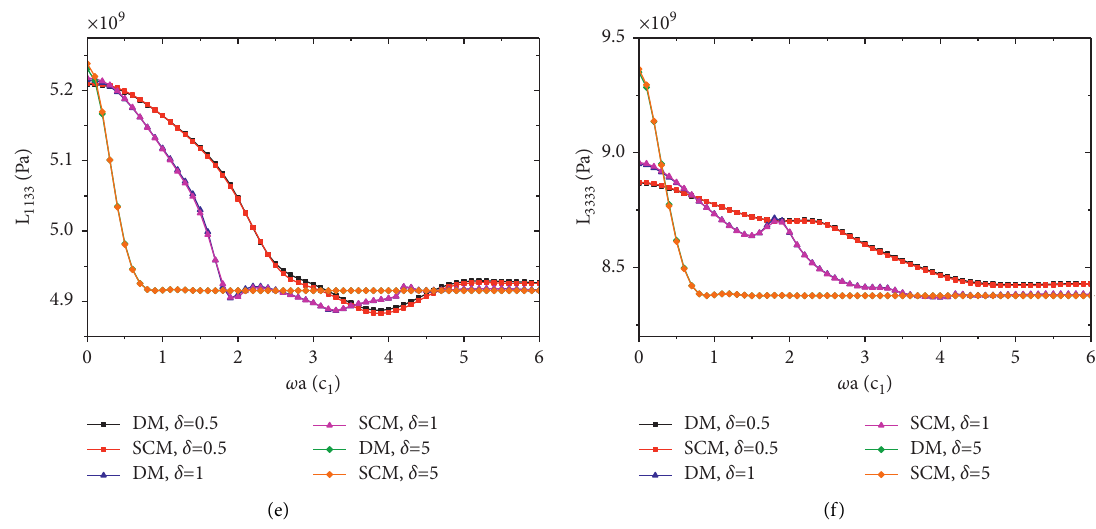
Figure 9: When quasi-P wave propagates in the composite material for inclusion volume fraction of 5.4% and δ � 0 . 5, 1, and 5, the dynamic and ρ and dynamic effective modulus L effective density ρ 11 33 self-consistent method (SCM),